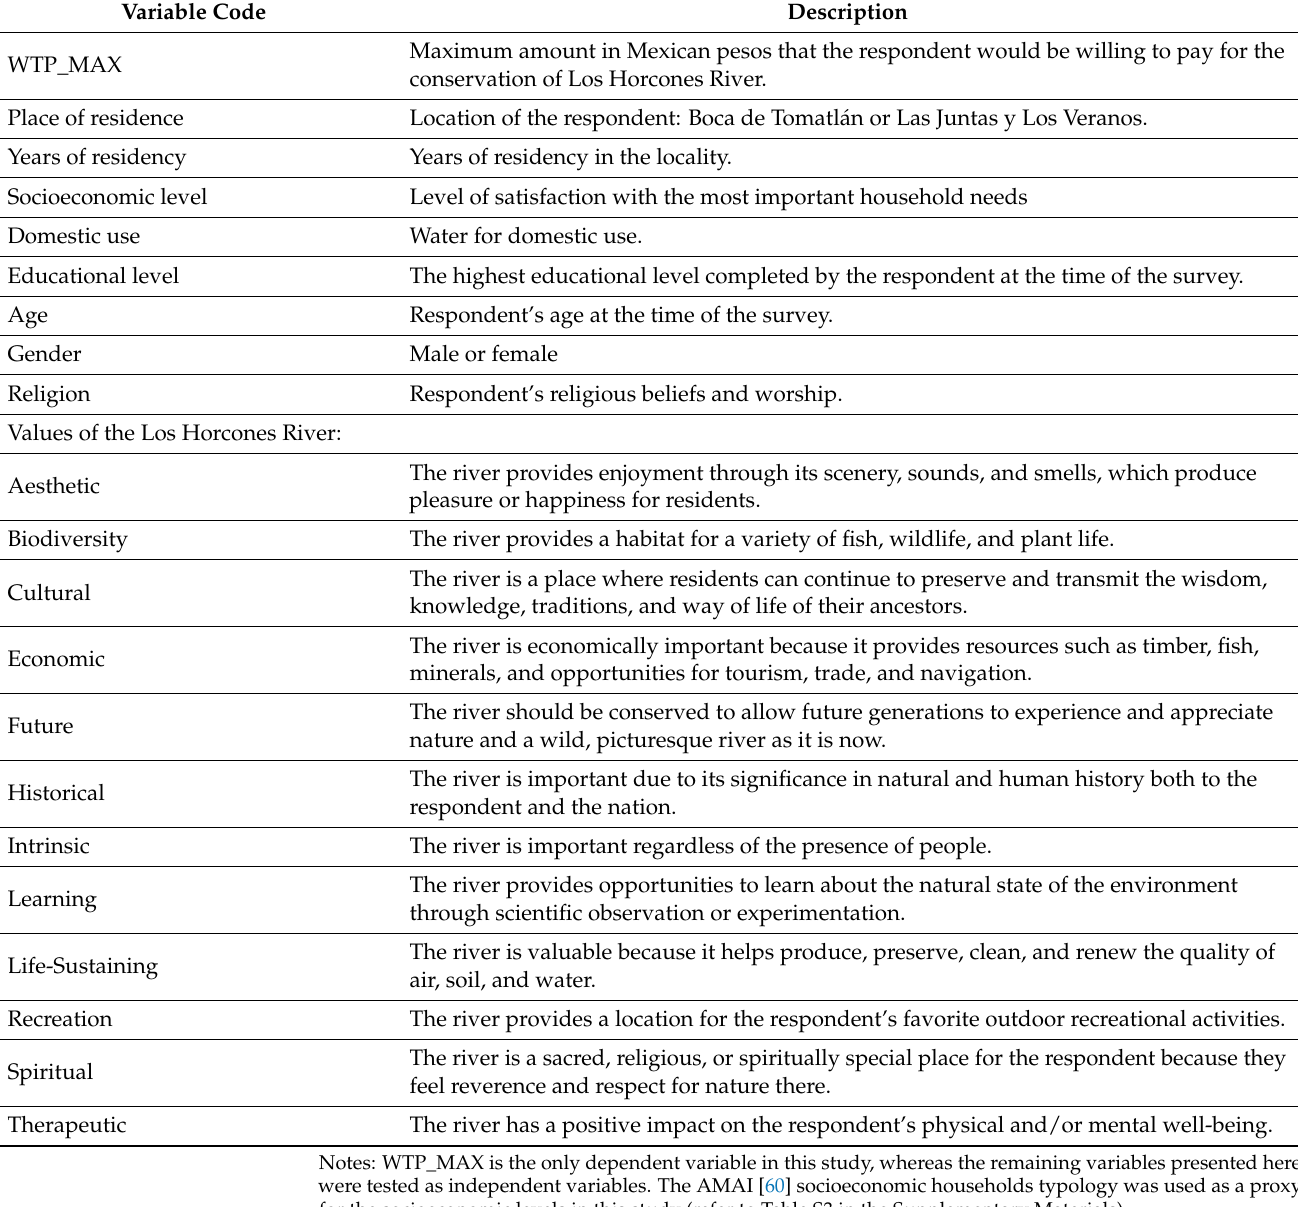
Table 1. The GLM incorporates a set of predictor variables to model the maximum amount in Mexican pesos (WTP_MAX) that local residents are willing to pay for the conservation of the Los Horcones River. These variables are considered as independent